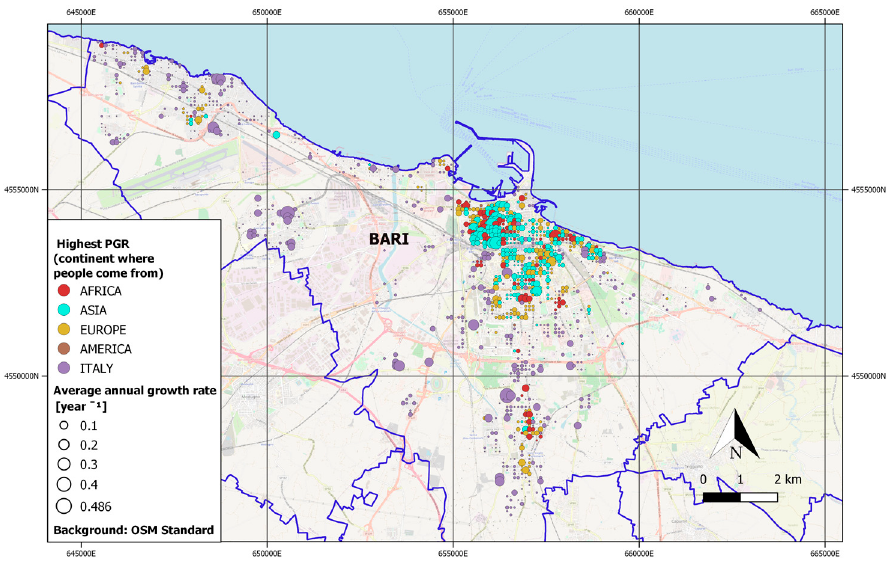
Figure 17. Highest Population Growth Rate (positive increase).